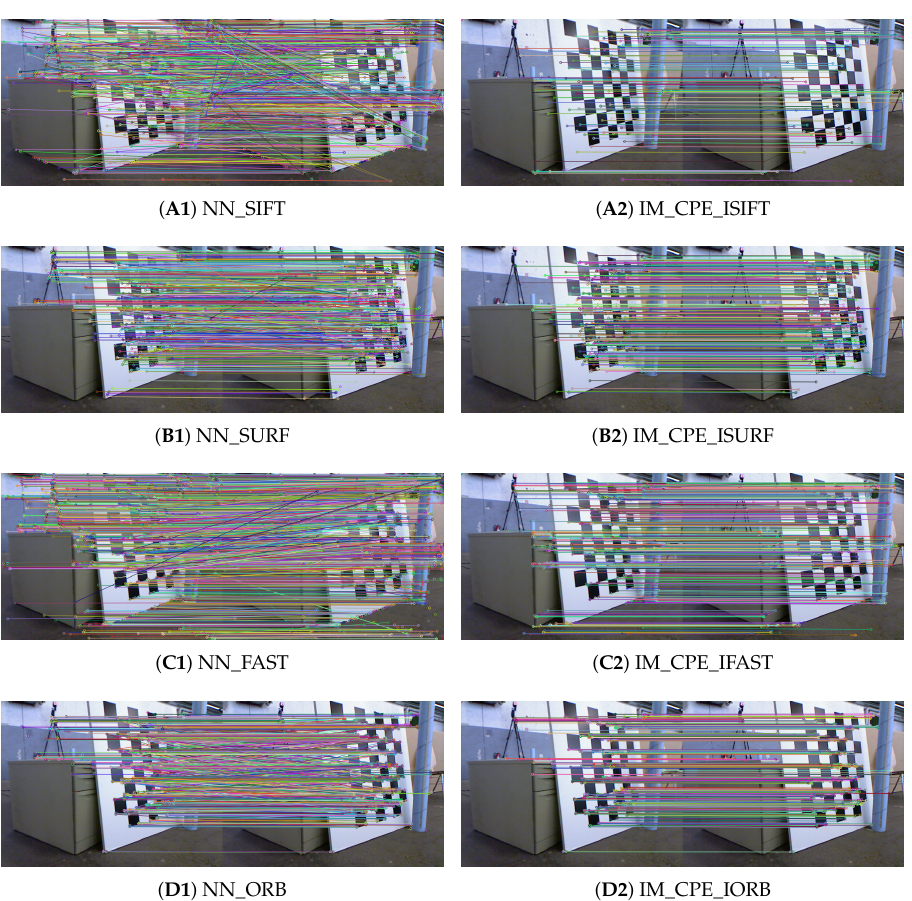
Figure 5. Comparison of matching result of ‘pioneer SLAM’ with the proposed IM_CPE and the existing NN method using different key points extraction methods: ( A1 ) NN Using SIFT (NN_SIFT) [3]; ( A2 ) proposed IM_CPE using improved SIFT (IM_CPE_ISIFT); ( B1 ) NN Using SURF (NN_SURF) [4]; ( B2 ) proposed IM_CPE using improved SURF (IM_CPE_ISURF); ( C1 ) NN Using FAST (NN_FAST) [47]; ( C2 ) proposed IM_CPE using improved FAST (IM_CPE_IFAST); ( D1 ) NN Using ORB (NN_ORB) [8]; ( D2 ) proposed IM_CPE using improved ORB